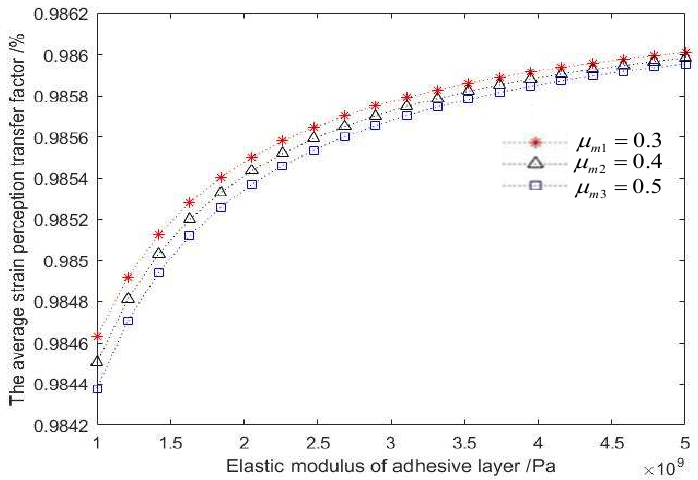
Figure 7. Effect of the adhesive layer elastic modulus on the average strain perception transfer factor. Combined with numerical simulations, the optimal parameters of the FBG-sensing encapsulation are determined by synthesizing the analysis of the degree of influence of each factor. The physical parameter values are shown in Table 1. Table 1. Physical parameters of the strain-sensing transfer model. Physical Parameters Numerical Value